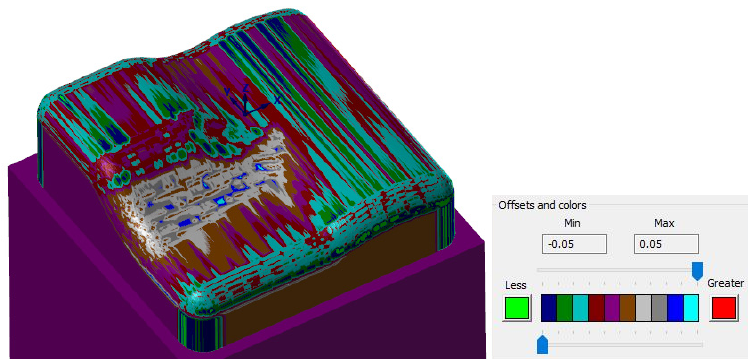
Figure 15. Diagram of the verification procedure of the machining accuracy.